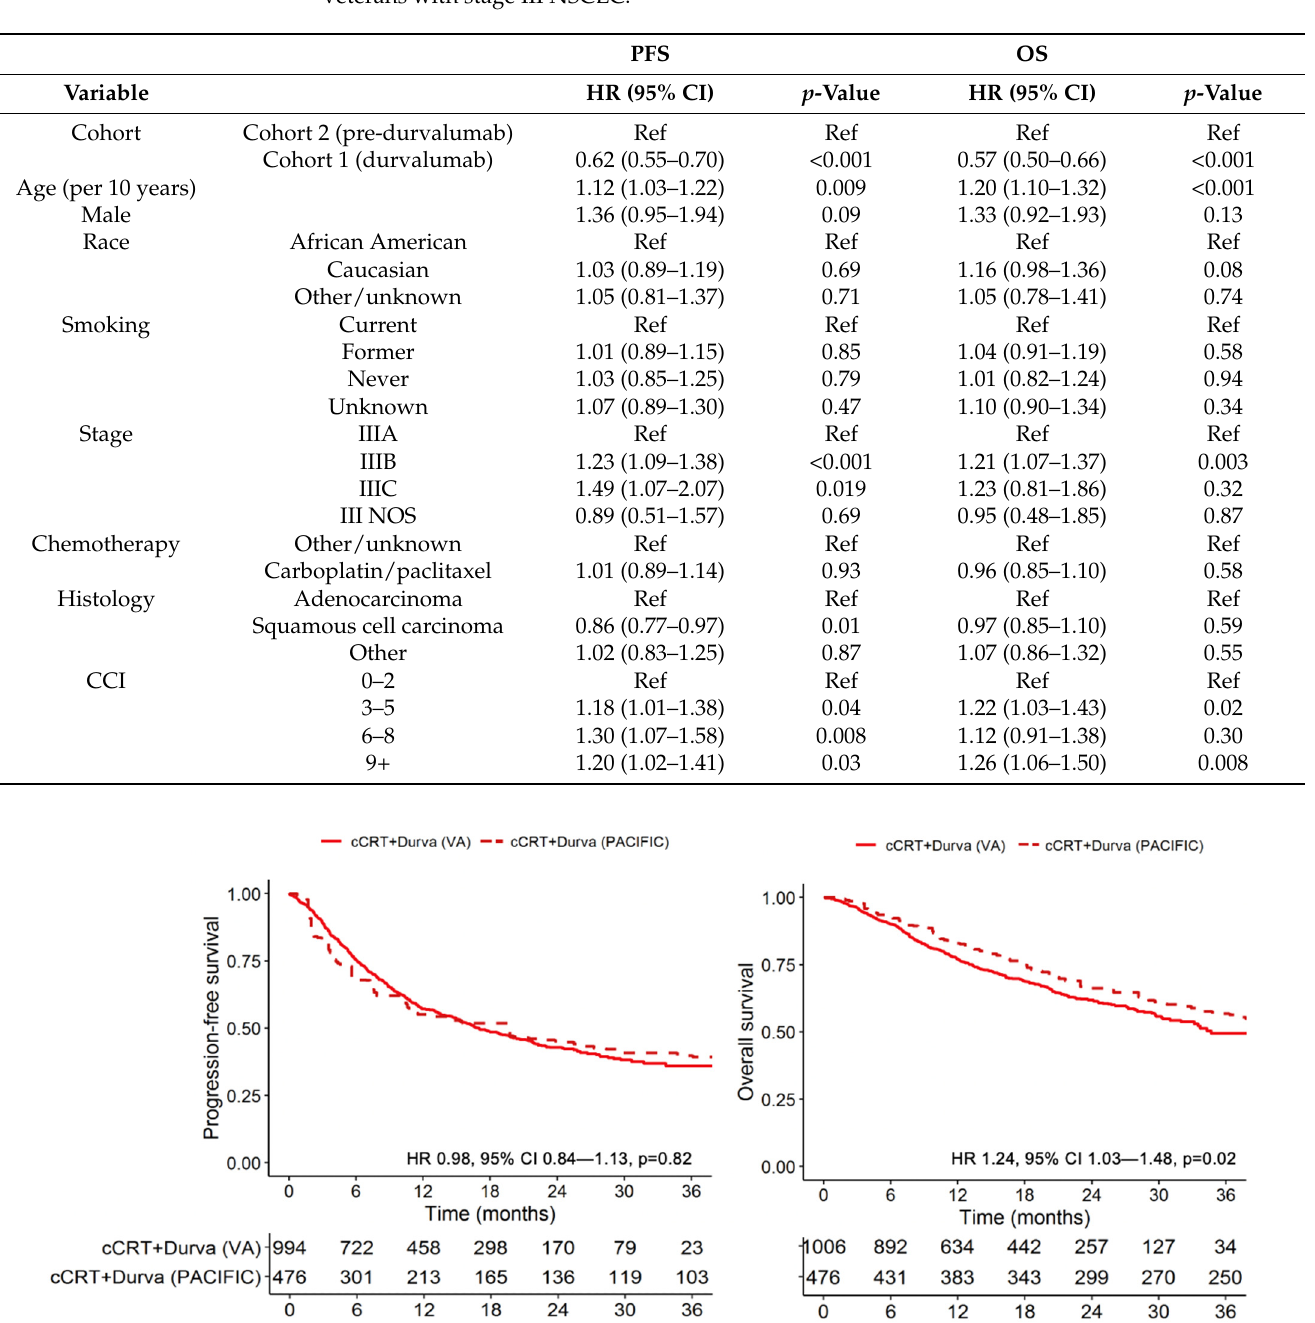
Table 2. Multivariable Cox regression analysis of progression-free survival and overall survival in veterans with stage III NSCLC.